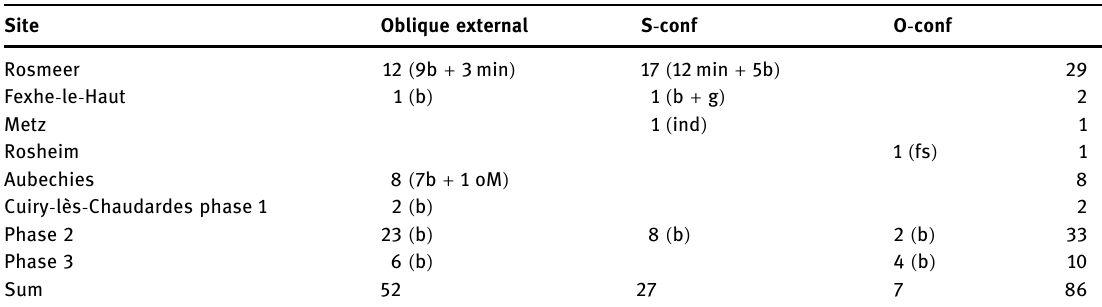
Table 3: Non - LBK pottery sherds studied in Gomart ( 2014 ) and categorized according to coiling method and temper ( in brackets